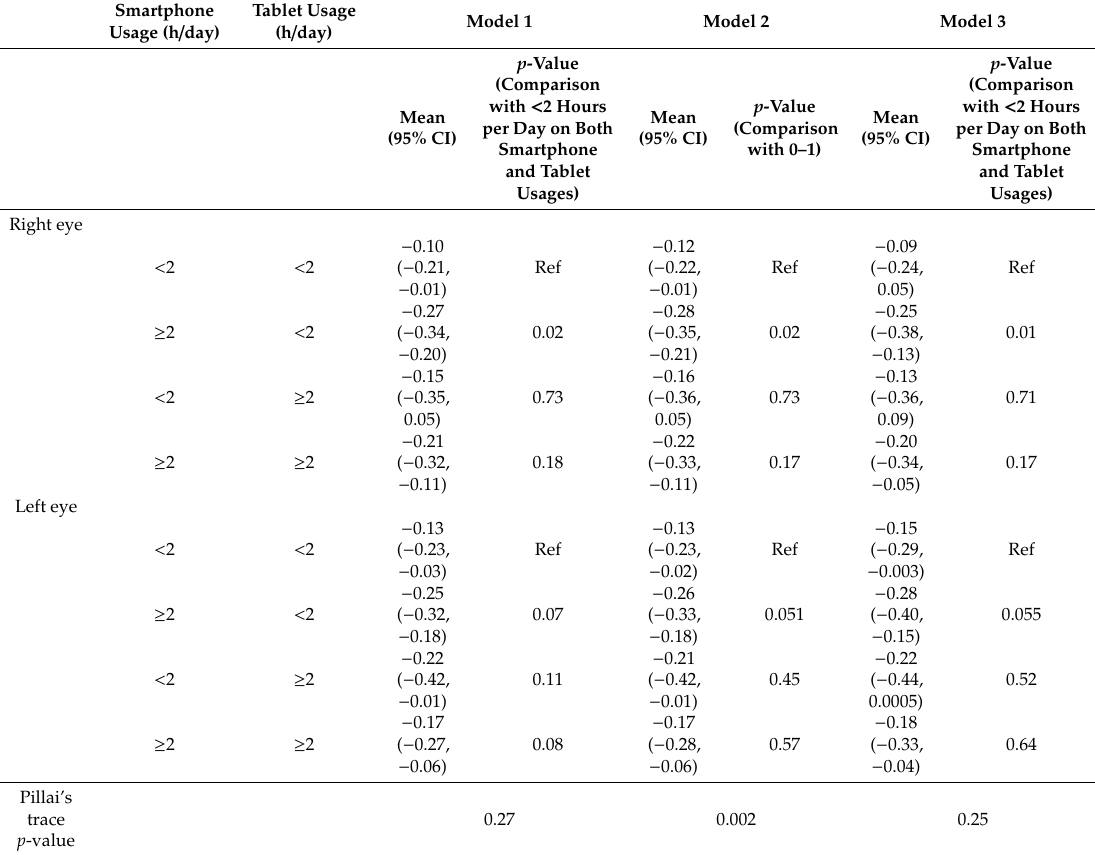
Table 6. Multivariate regression of the interactive e ff ect of smartphone and tablet usage ( < 2 h per